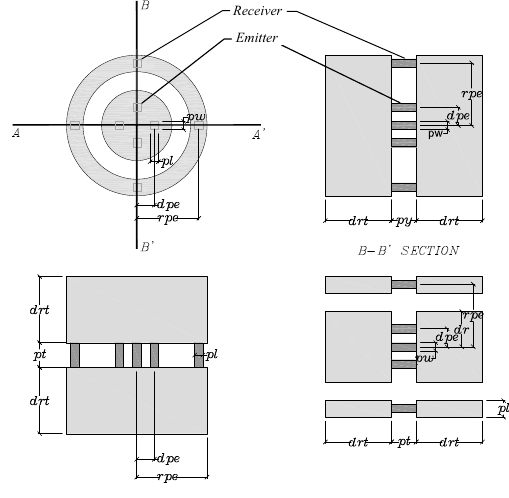
Figure 4. Transducer geometry. Piezoelectric elements in dark gray. Emitters at the inner